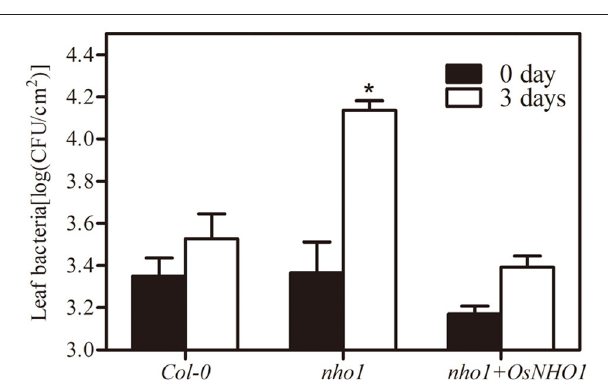
FIGURE 3 | Bacterial growth of P. s . phaseolicola in Col-0, nho1 mutant, and nho1 + OsNHO1 lines was measured at 0 and 3 days after inoculation. Asterisks indicate significant differences compared with the other two varieties at 3 days ( p < 0.05) by one-way ANOVA followed by the Tukey’s highest significant difference (HSD) analysis. The error bars indicate the SEs. Three independent experiments were performed with similar